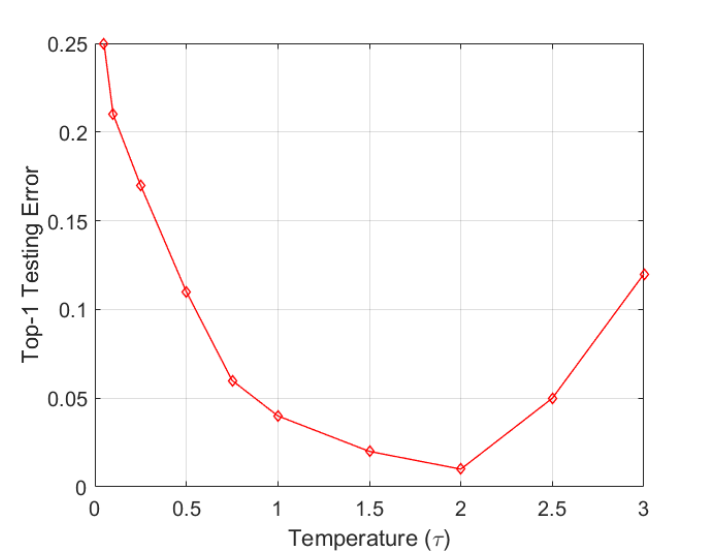
Figure 7. Effect of τ in terms of the top-1 testing